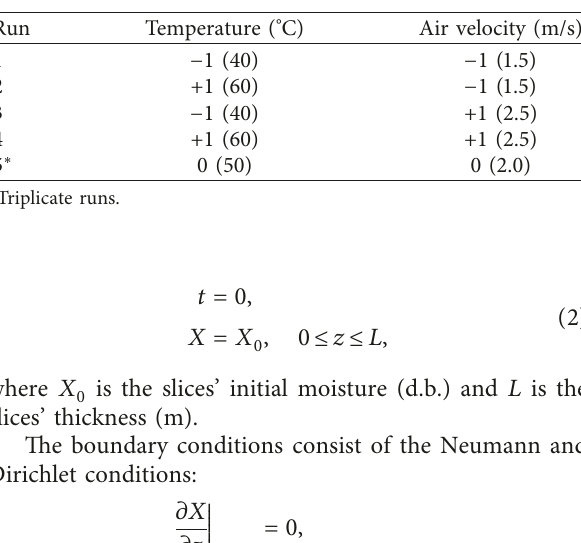
Table 1: Experimental design (coded and real values) used to determine the drying conditions of red araç´a